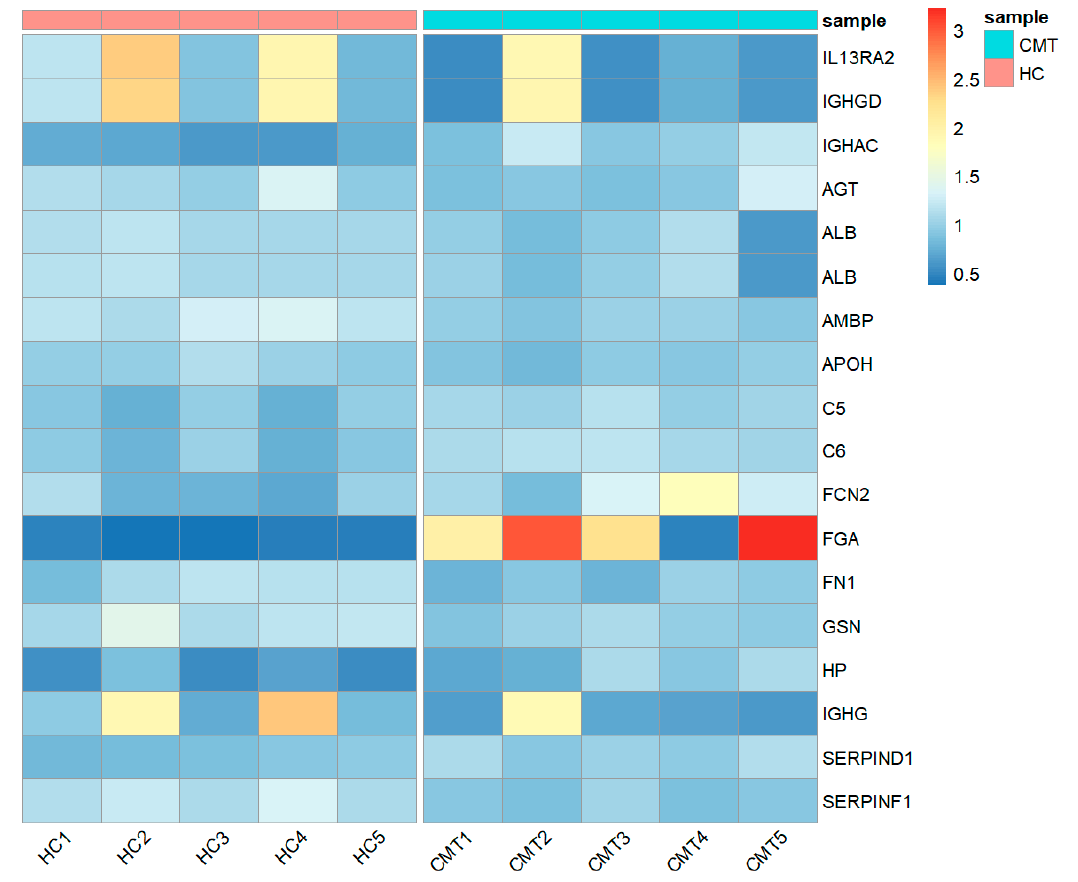
Figure A1. Heatmap showing the relative abundance (color) of serum proteins in healthy (HC) dogs and dogs with canine mammary tumors (CMT).